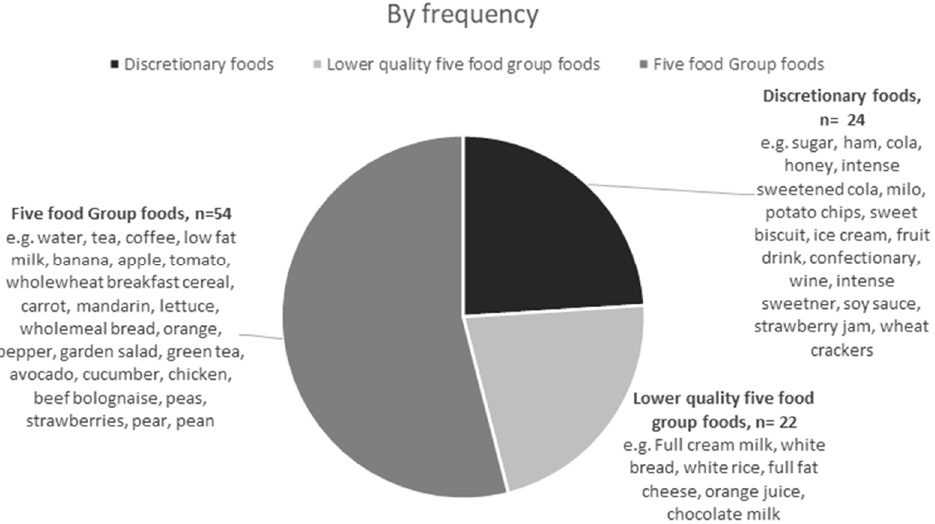
Figure 2. Number of the 100 most popular foods by frequency that were classified as five food group, lower quality five food group and discretionary foods, with a selection of the foods in each category listed.